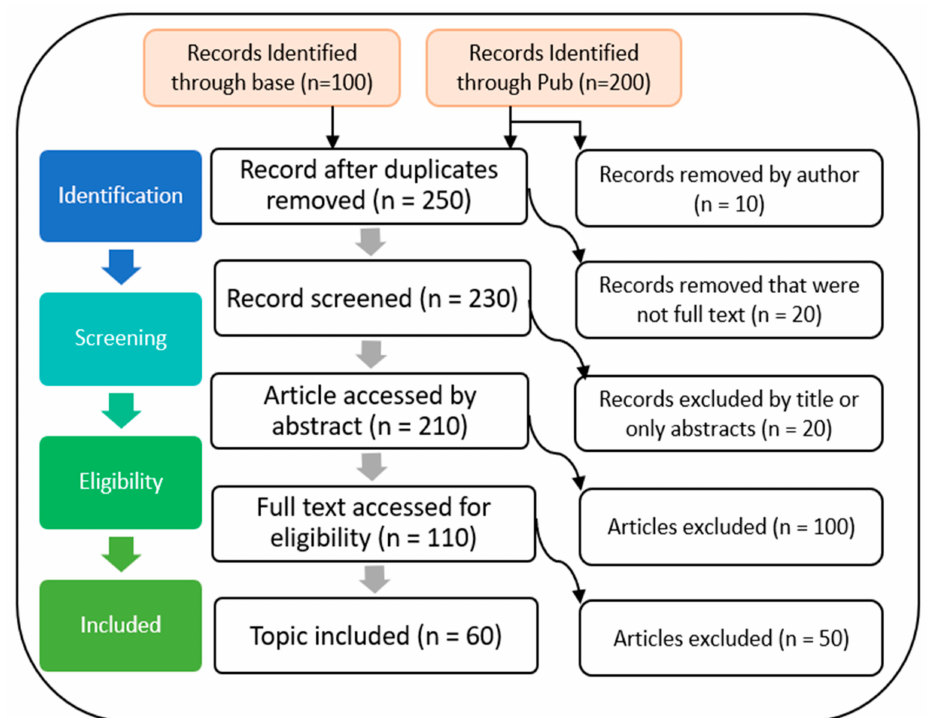
Figure 1. Guidelines for the review